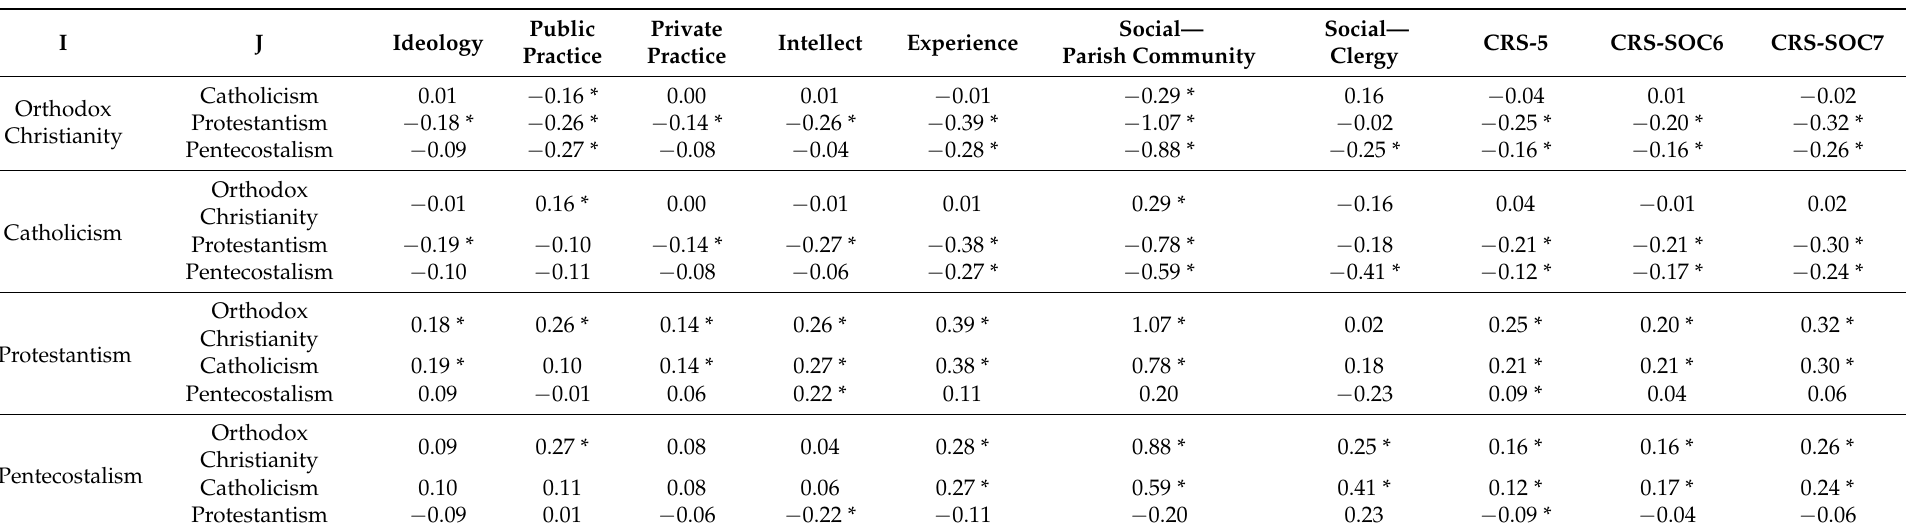
Table A2. Multiple Comparisons. Tamhane criterion (mean difference,